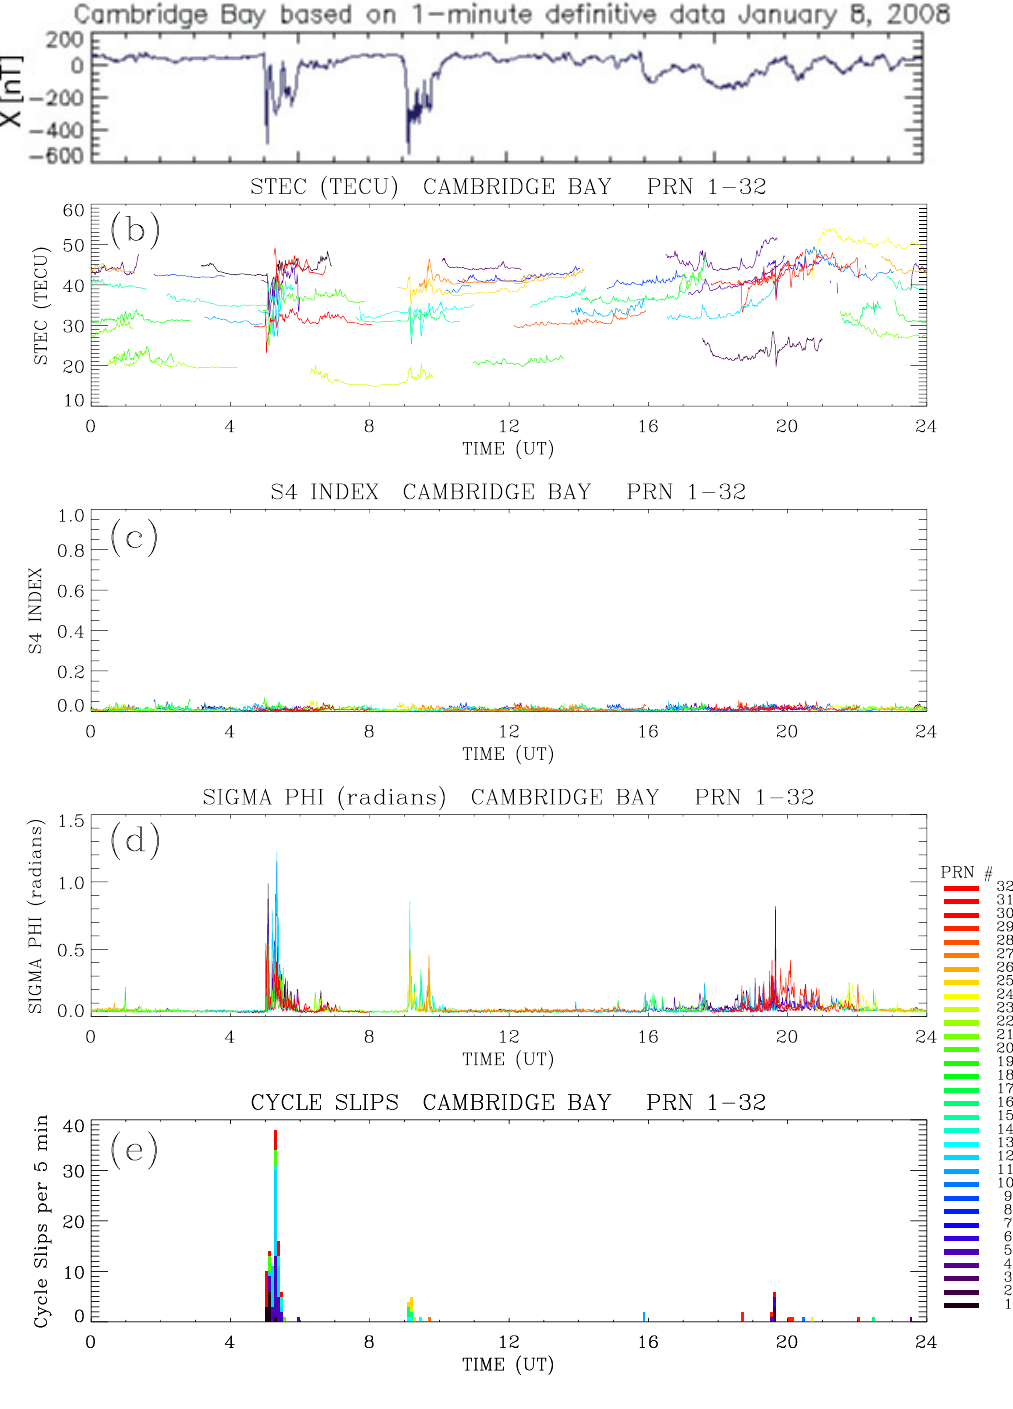
Fig. 2. (a) The magnetic field X component, (b) slant TEC, (c) S4 index, (d) phase scintillation and (e) number of cycle slips observed in Cambridge